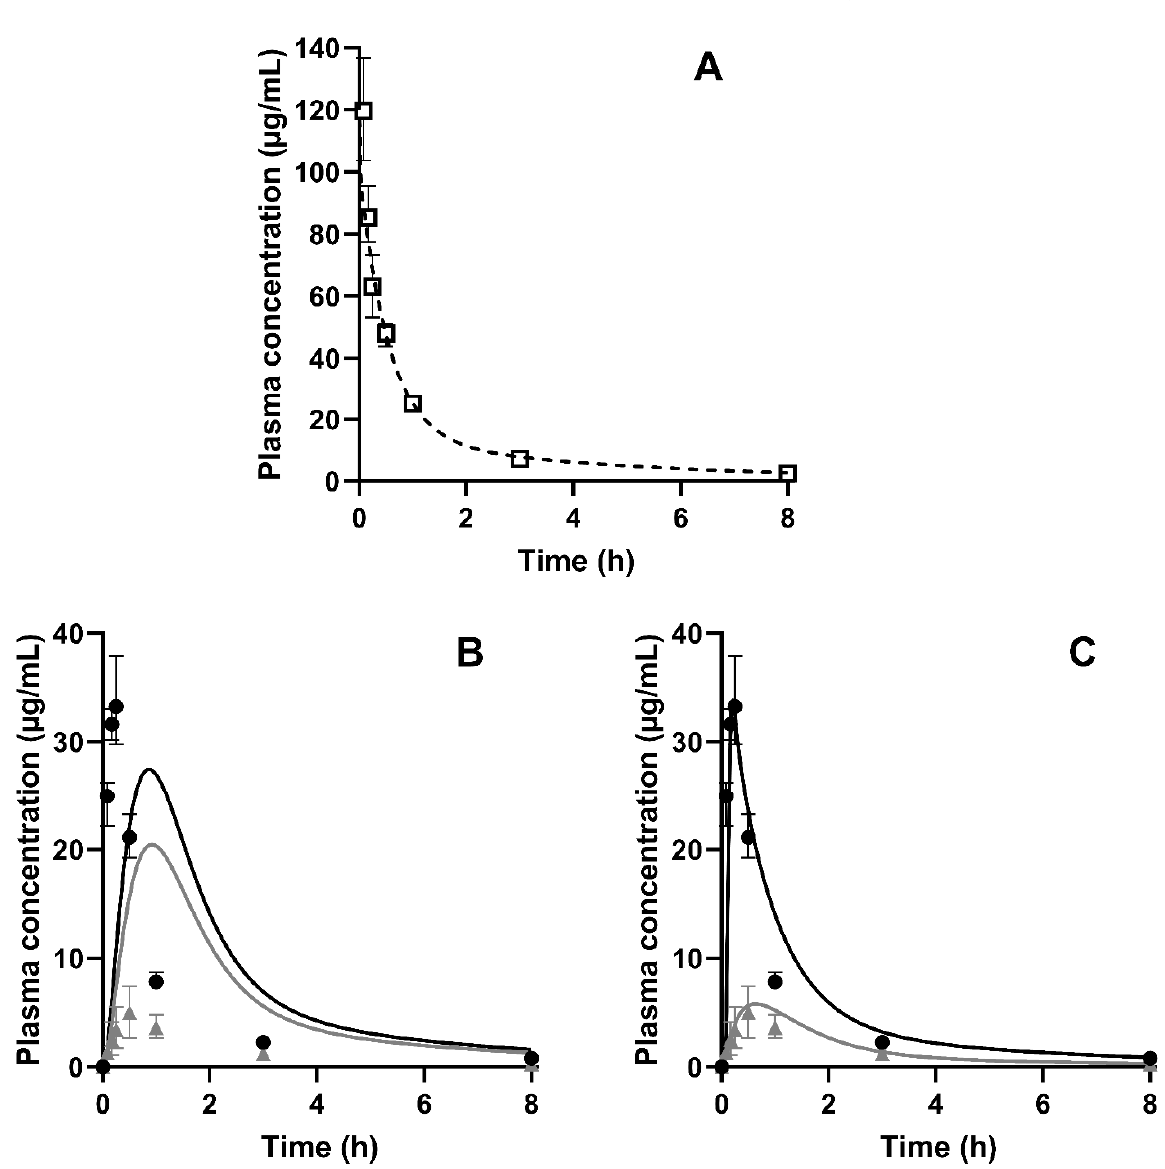
Figure 8. Observed and predicted plasma profiles of CorA in BALB/c mice ( n = 4 per group); ( A ): Dashed line represents the prediction of IV administration ( B ): Lines represent the prediction of PO administration of CorA-povidone (black) and CorA-copovidone (grey), based on immediate release; ( C ): Lines represent the prediction of PO administration of CorA-povidone (black) and CorA-copovidone (grey), based on dissolution data; ( □ ) represents observed data following the IV administration, ( ● ) represents observed data following PO administration of CorA-povidone and ( ▲ ) represents observed data following PO administration of CorA-copovidone, respectively.